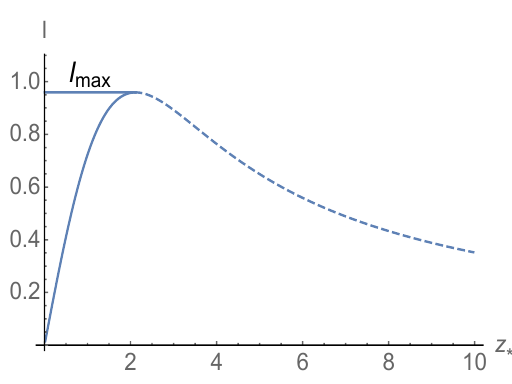
Figure 4 . (cid:1) S EE = S EE of ‘ in the thermal-AdS background. In units GeV.